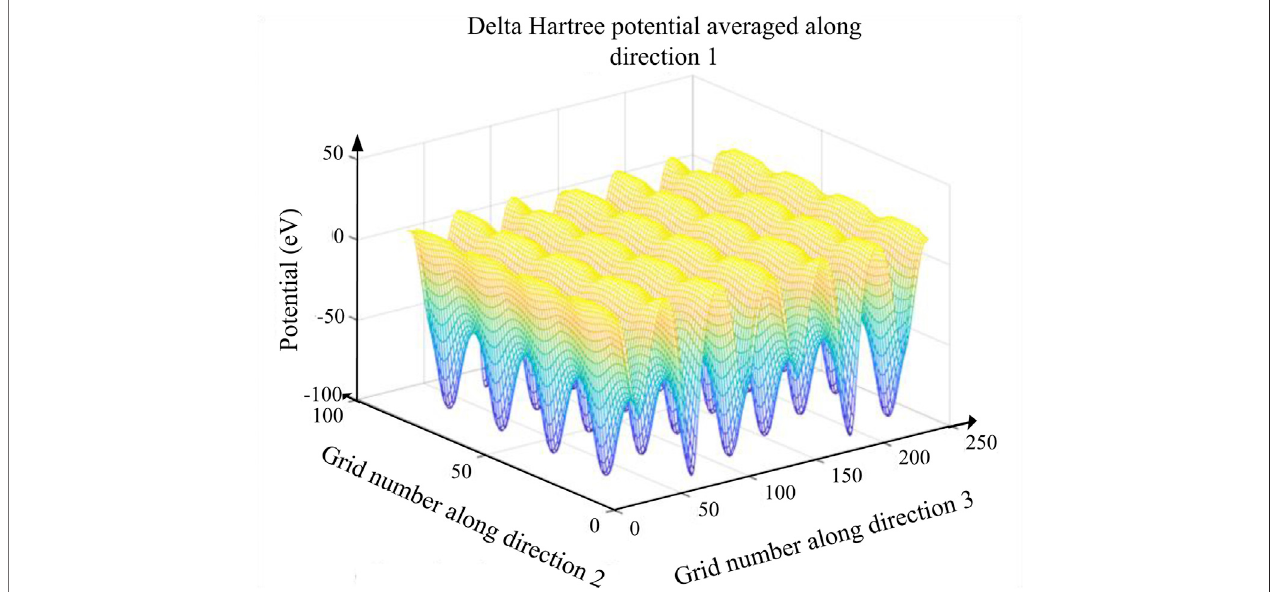
FIGURE 6 | 3D potential energy pro fi le of Li 0.9 Al 0.1 Ni 1/3 Co 1/3 Mn 1/3 O 2 . The different colors correspond to the different potential energy. When x < 0.11 mol, all 3D potential energy maps show that the potential barrier is getting lower after Al doping.